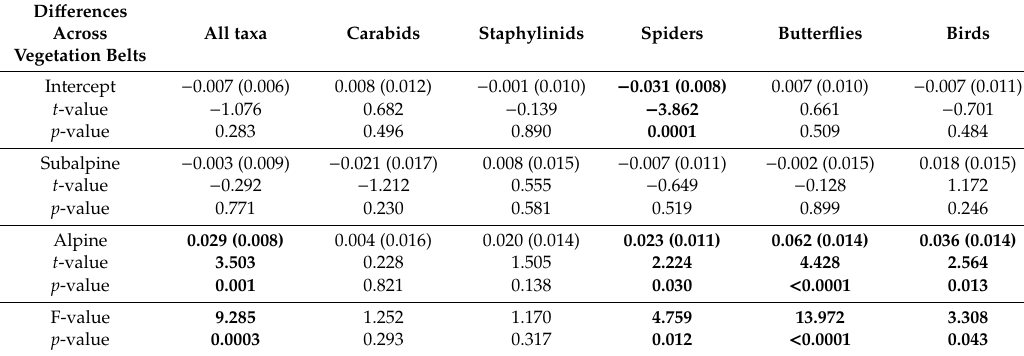
Figure 4. Changes in species richness along the altitudinal gradient. Scatterplot of the e ff ect size (index) as a function of elevation (m a.s.l.), for all taxa pooled together and for each taxon separately. The colored lines represent LOESS smoothing and the grey bands indicate confidence intervals. Table 3. Di ff erences across vegetation belts. Results of the analysis of e ff ect size across vegetation belts by linear mixed e ff ect models, for all taxa pooled together and for each taxon separately (DF = 496 / 59 / 59, plot identity included as a random e ff ect). The baseline is the montane belt. The estimates (and the standard errors) of the fixed e ff ects are reported, followed by t -values and p -values. The ANOVA test of the global e ff ect of the variable “model class” is also reported in the lower two rows (F-value and p -value). Significant values are indicated in